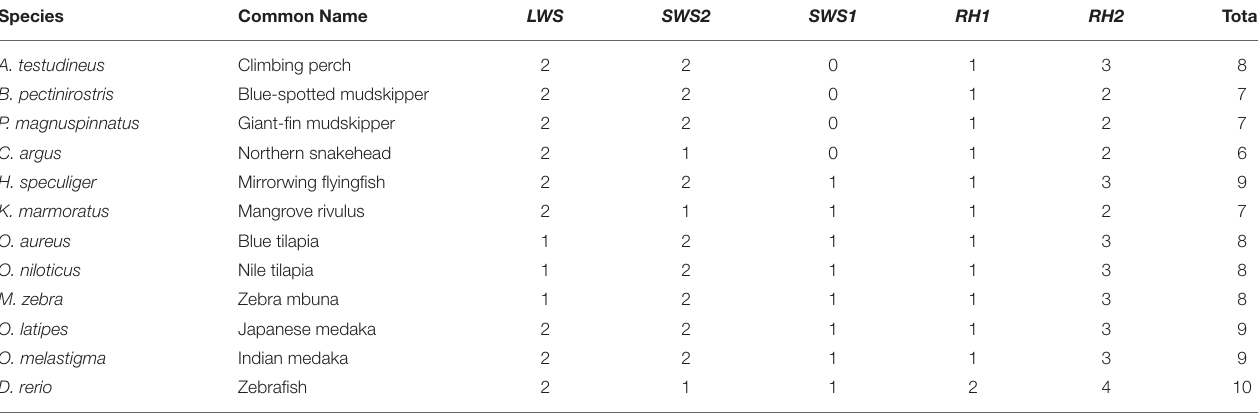
TABLE 3 | Copy number of vison-related genes in the 12 representative teleost fishes. Species